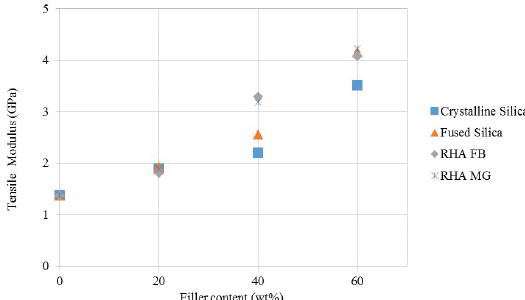
Figure 15. Elasticity modulus of composites (GPa). Effect of the percentage of filler on the elasticity modulus under tensile